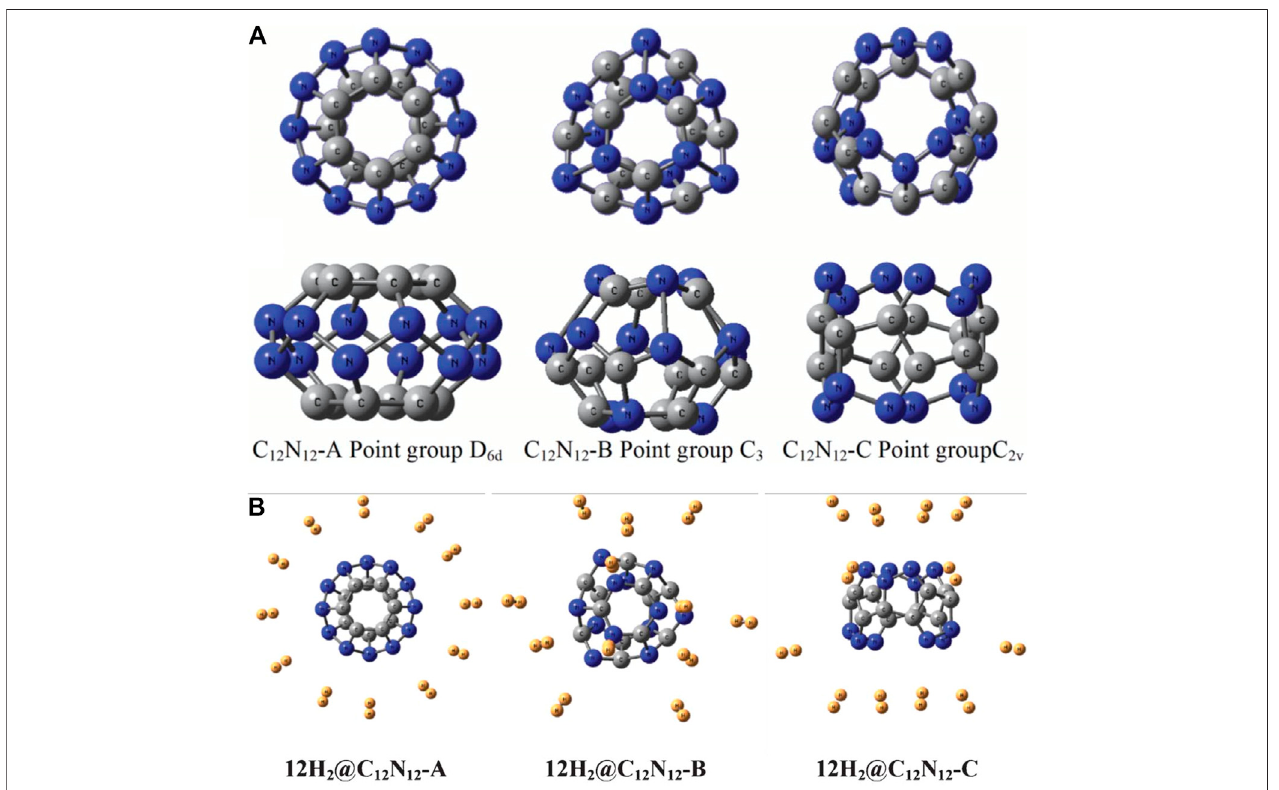
FIGURE 10 | The optimized geometries of (A) the three isomers of C 12 N 12 cage (top and side view) , and (B) their respective 12 H 2 loaded structures at B3LYP- D3/6-31G(d) level of theory (Reproduced from Mondal et al., 2013 with permission from the Royal Society of Chemistry).